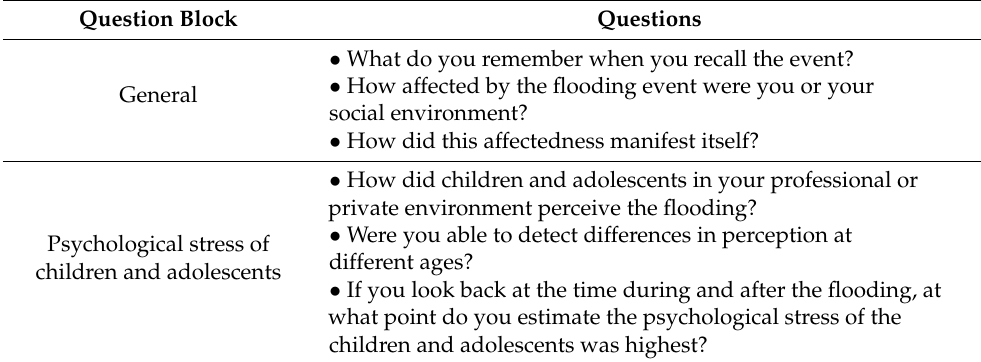
Table 1. Interview